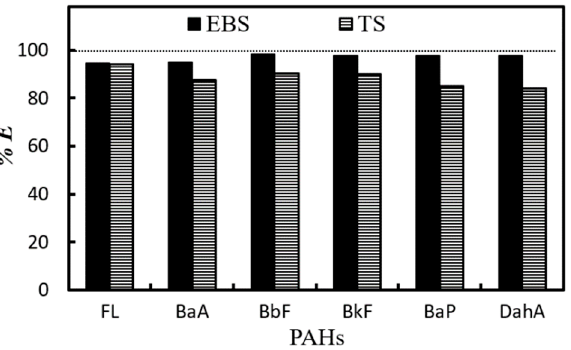
Figure 3. Comparison of the percent extraction (% E ) of PAHs in IAPs with different components, BTC-EBS − and BTC-TS −